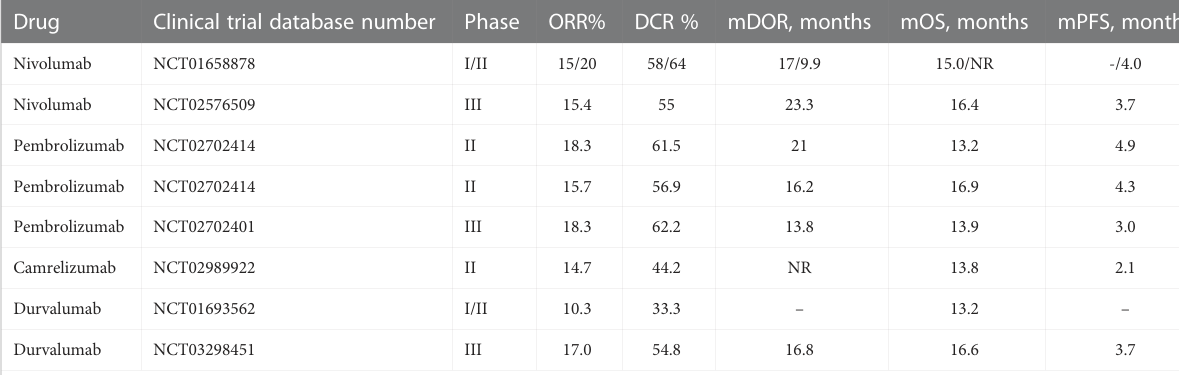
TABLE 1 Clinical trial results of anti PD1/PD-L1 monotherapy for HCC. Drug Clinical trial database